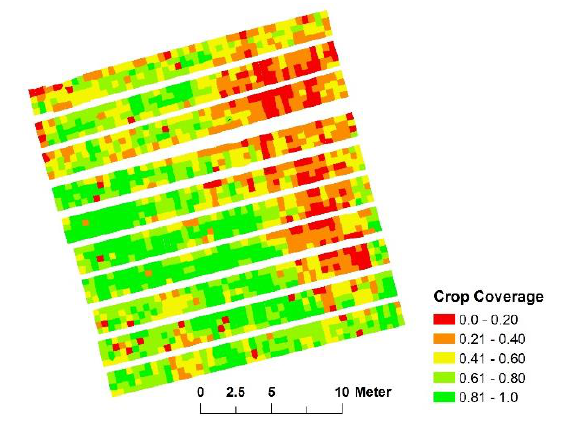
Figure 5: Proportion of crop coverage per single plant of the 2nd drone flight. Red plants are either small or not growing well,